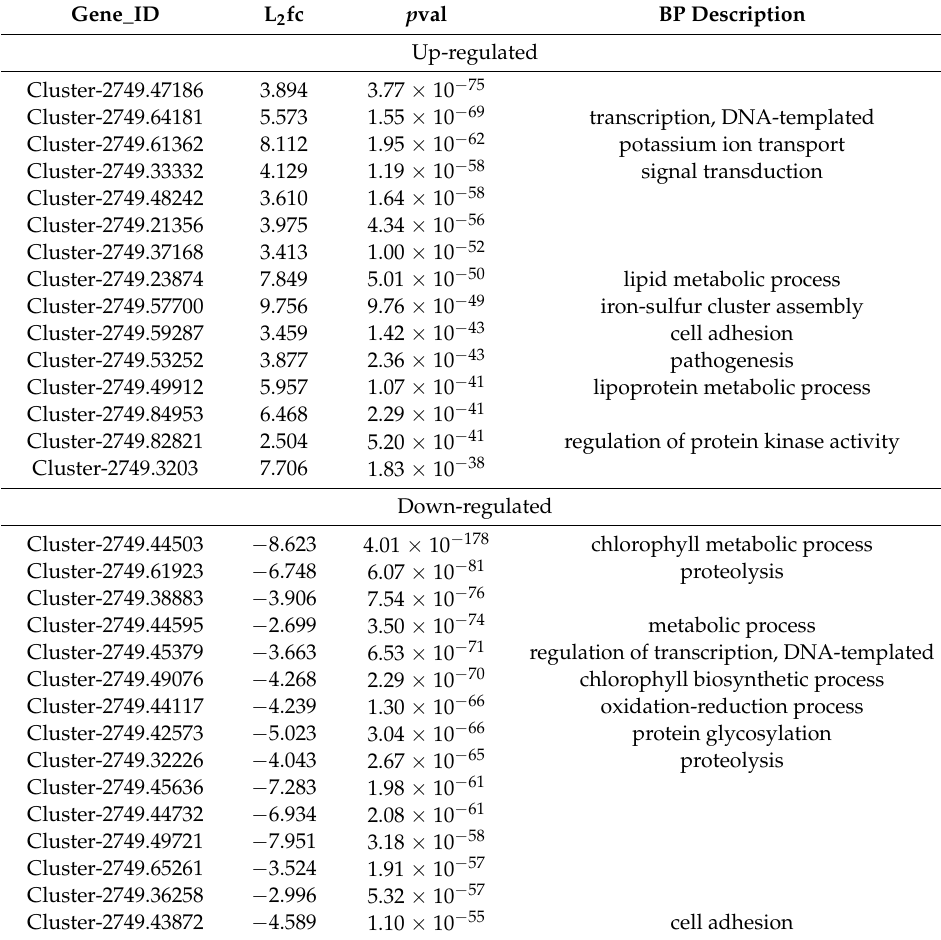
Table 2. Top30 dysregulated genes in C. reinhardtii under 200 mM NaCl treated and control